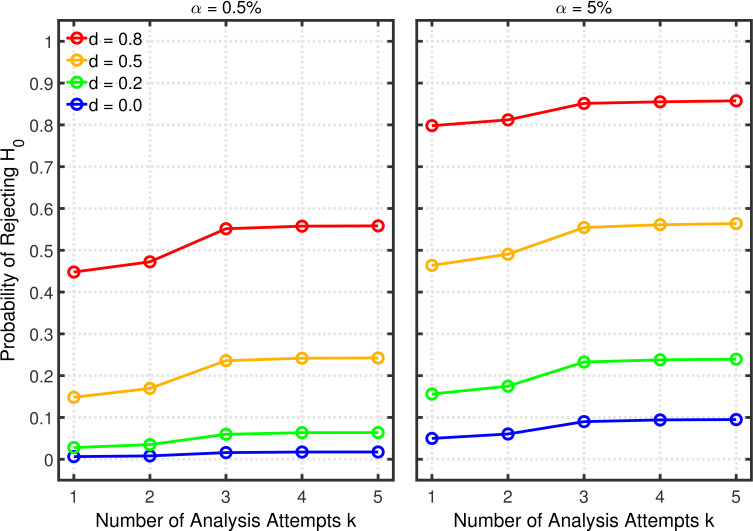
Selective outlier removal.Estimated probability of rejecting H0 as a function of the number k of outlier rejection methods attempted for various effect sizes d, and nominal α level (0.5% or 5%). Probability estimates were based on 10,000 simulated experiments. Simulated data included no outliers.